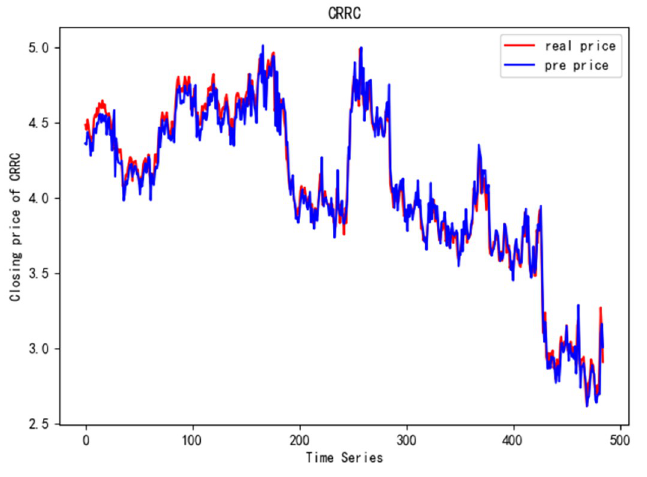
Fig 11. Closing price of CRRC.